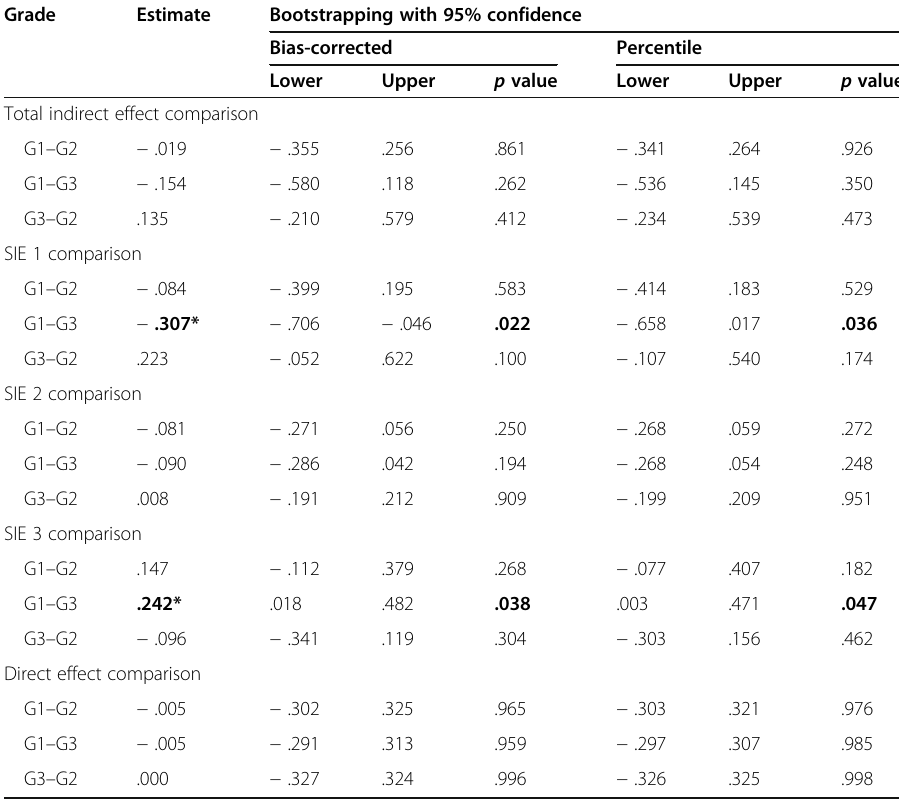
Table 8 Moderated mediation analysis: indirect and direct effect comparison among the three grades Grade Estimate Bootstrapping with 95% confidence Bias-corrected Percentile Lower